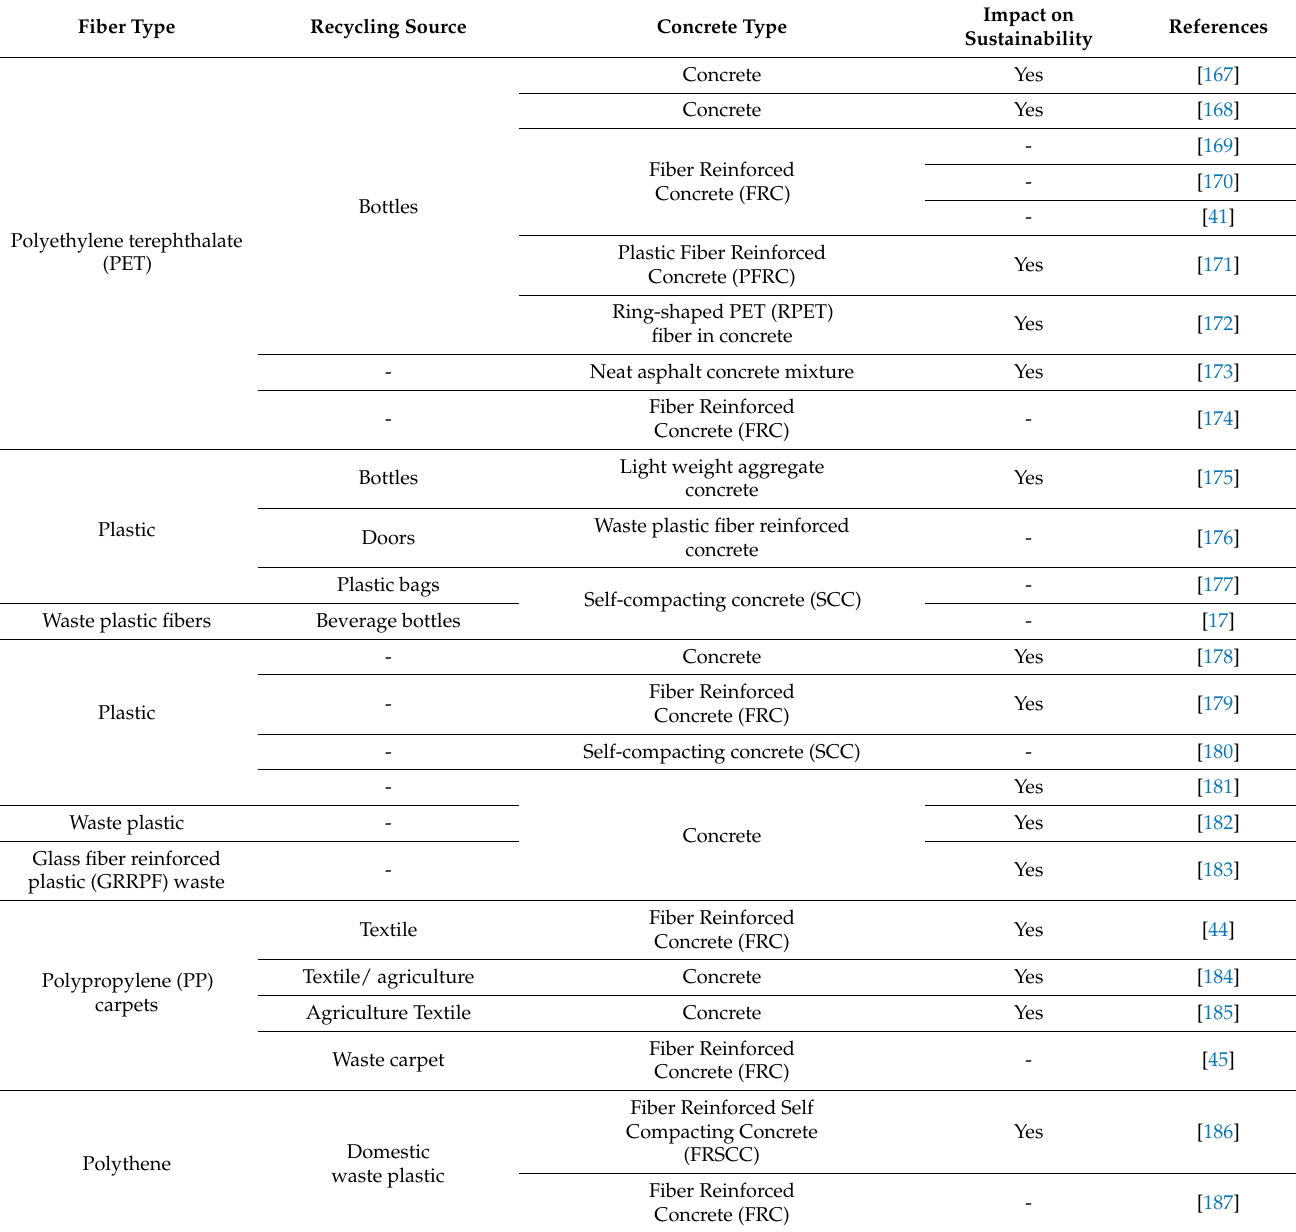
Table 2. Different recycled-waste fibers used in cement-based